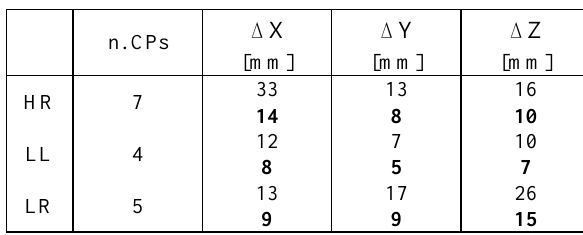
Table 5. UAV photogrammetric block - CPs residual errors along Vallone d'Elva road.